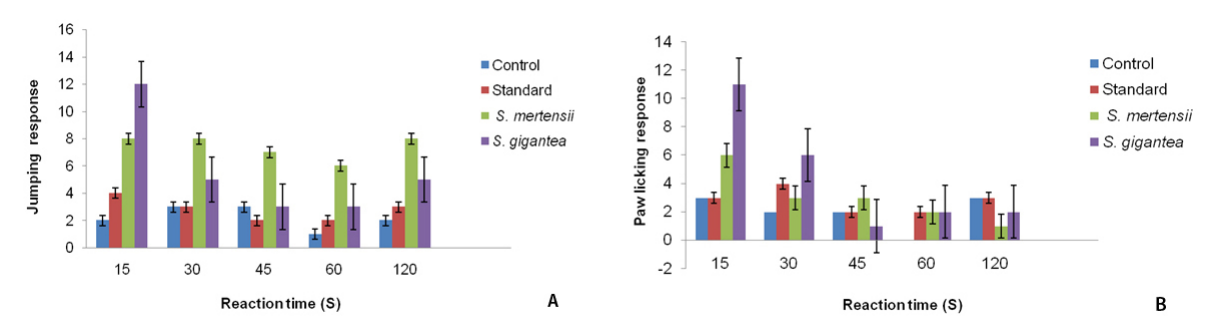
Figure 4. Analgesic activities of 20 ± 2 g male albino mice produced by S. mertensii and S. gigantea extract at 2 mg.kg –1 under the hot plate